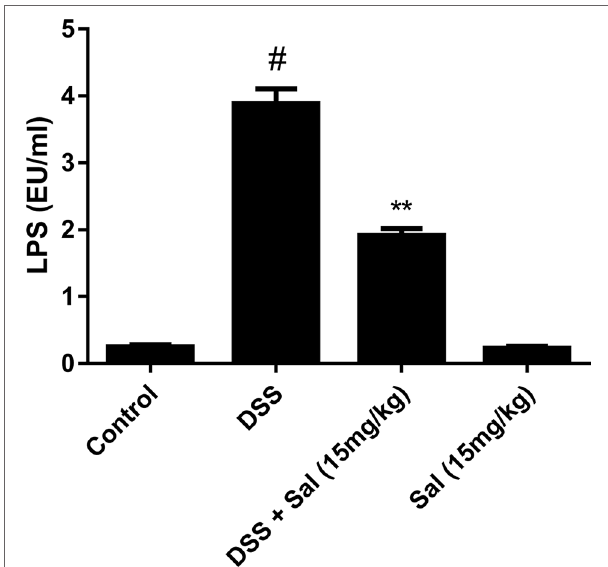
FIgURe 8 | Salidroside reduced plasmatic lipopolysaccharides (LPS) concentration in dextran sulfate sodium (DSS)-treated mice. Limulus amebocyte lysate assay was used to assess the plasmatic LPS concentration. Data are presented as means ± SD. (*) p < 0.05 vs . the DSS-treated group; ( # ) p < 0.05 vs . the control